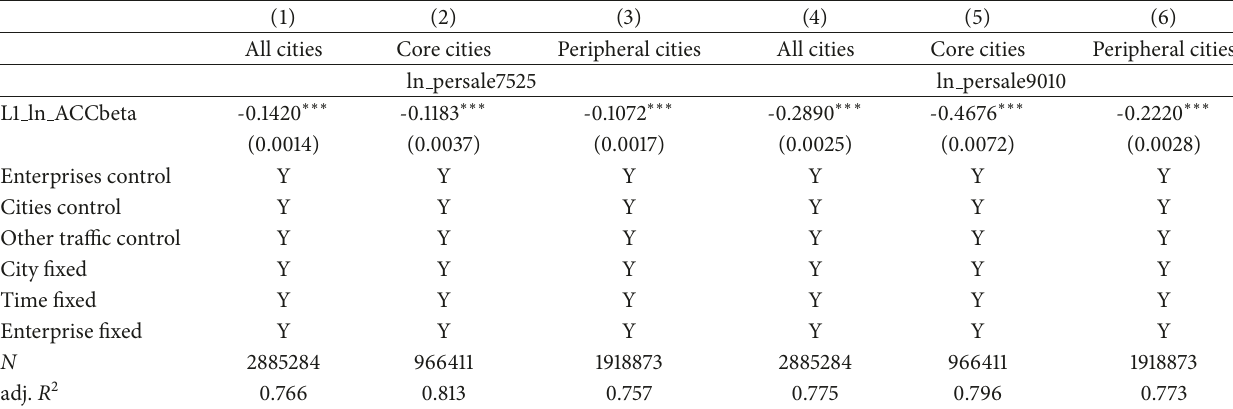
Table 14: Regression analysis of market access and resource mismatch.